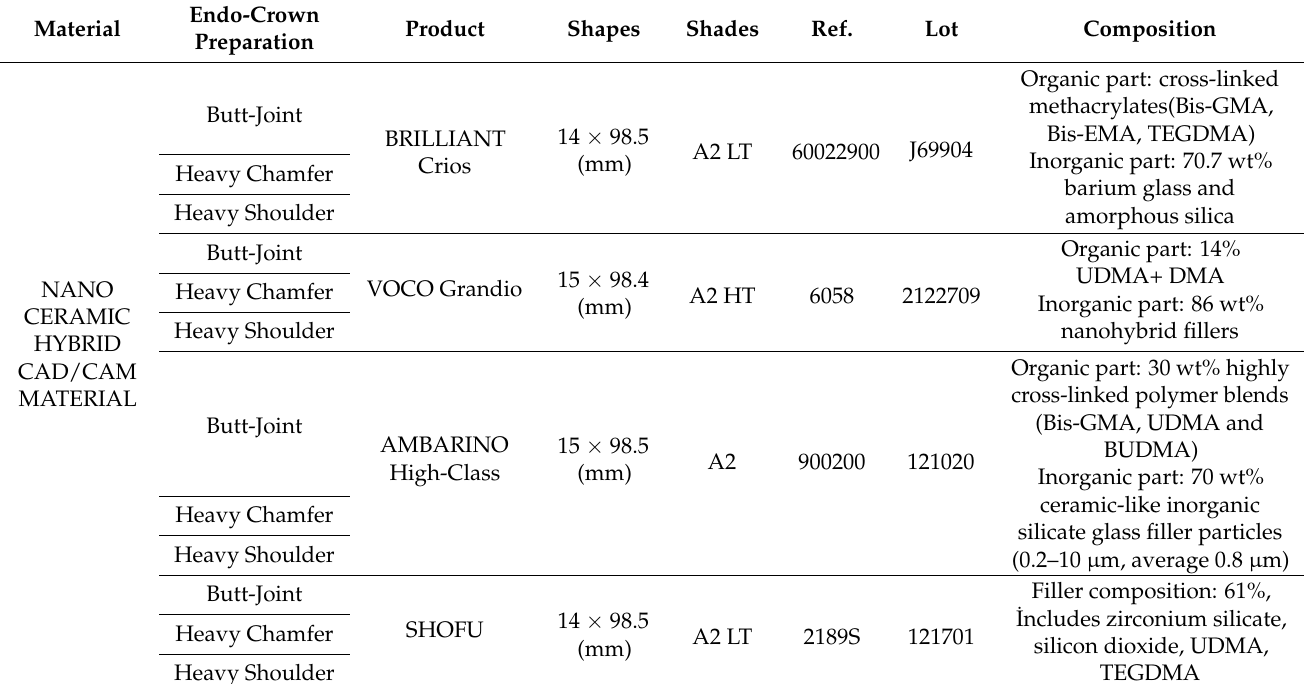
Table 1. Margin design, product, shapes, shades, ref, lot numbers and the composition of the CAD ‐ CAM materials used in this study.